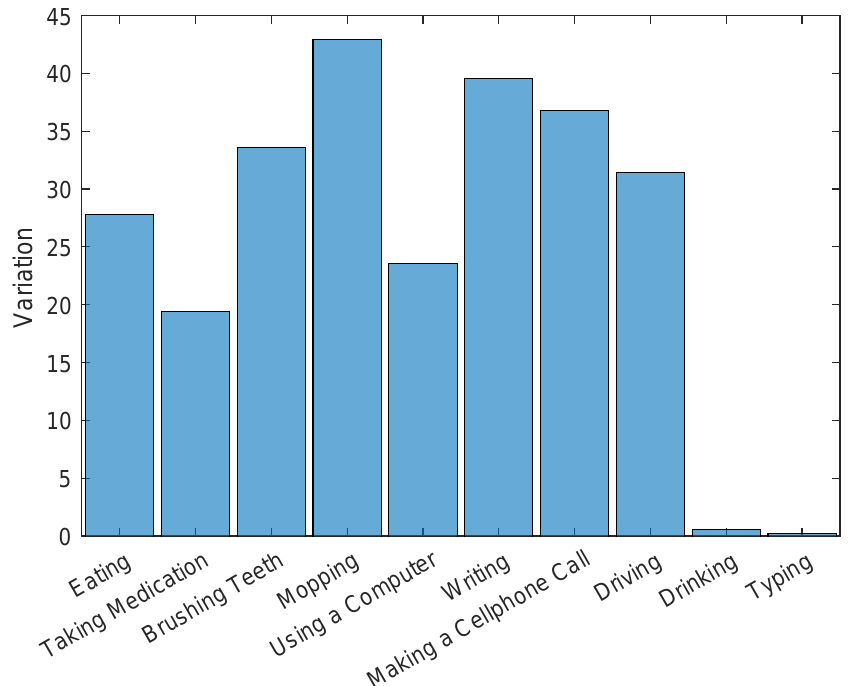
Figure 5. Variation values for the activities of Dataset variations and two other simple activities (i.e., Drinking and Typing ).